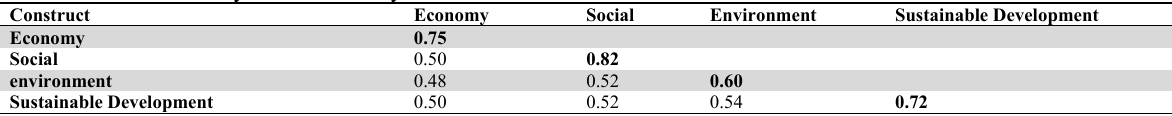
The Discriminant Validity Index